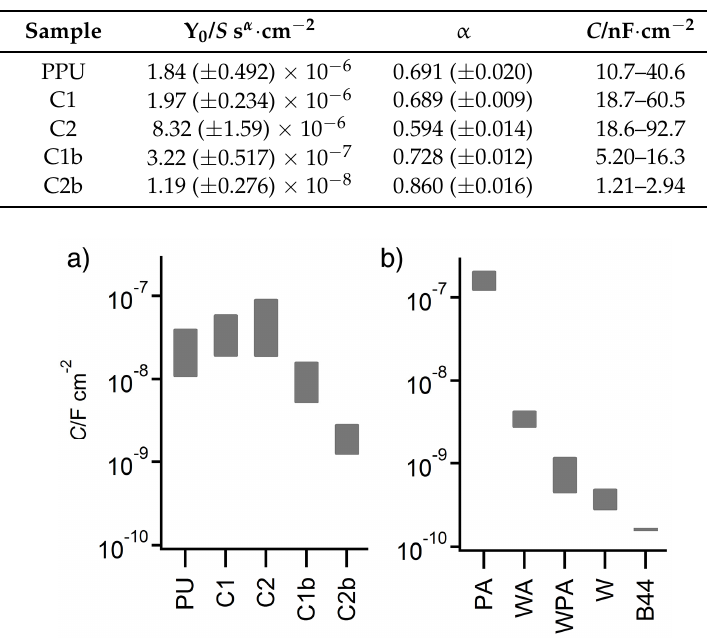
Table 2. CPE fit parameter values and errors for aged and fresh wax on bronze sculptures and the calculated capacitance range from equation 6 over the frequency range of the fits (316–15.9 kHz), except for C2b which was calculated over 1000–79.5 kHz due to the higher frequency onset of noise in the spectrum. The CPE parameter fitting errors are incorporated into the calculated capacitances, which are visualized in Figure 5a.